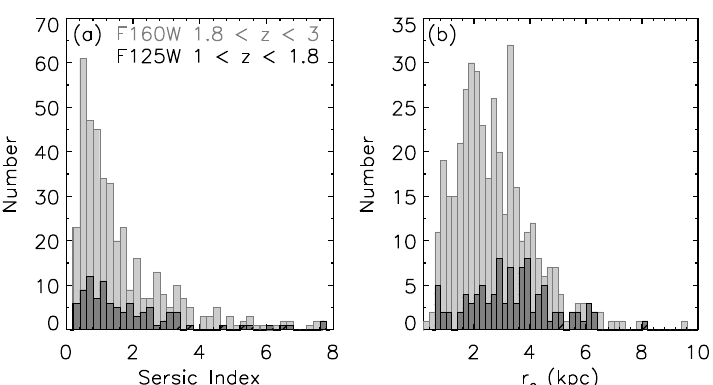
Fig. 2. S´ersic index ( n ) and effective radius ( r e ) histograms of ULIRGs in our sample in different redshift bins. The left panel (a) is the distribution for n , and the right panel (b) is the distribution for r e